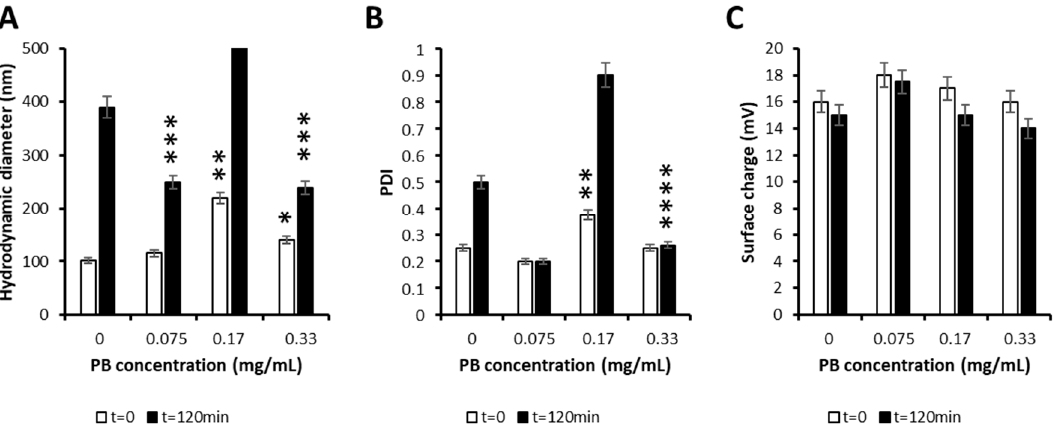
Figure 4. Physicochemical characterization of PB-coated pBAE-NPs. ( A )—Size (nm); ( B )—PDI; and ( C )—Surface charge of PB-coated nanoparticles, as a function of PB concentrations, at initial and after 120 incubation. Statistical test comparing each condition with nanoparticles without the coating (at initial or final times). * p < 0.05; ** p < 0.01; *** p < 0.001; **** p < 0.0001.